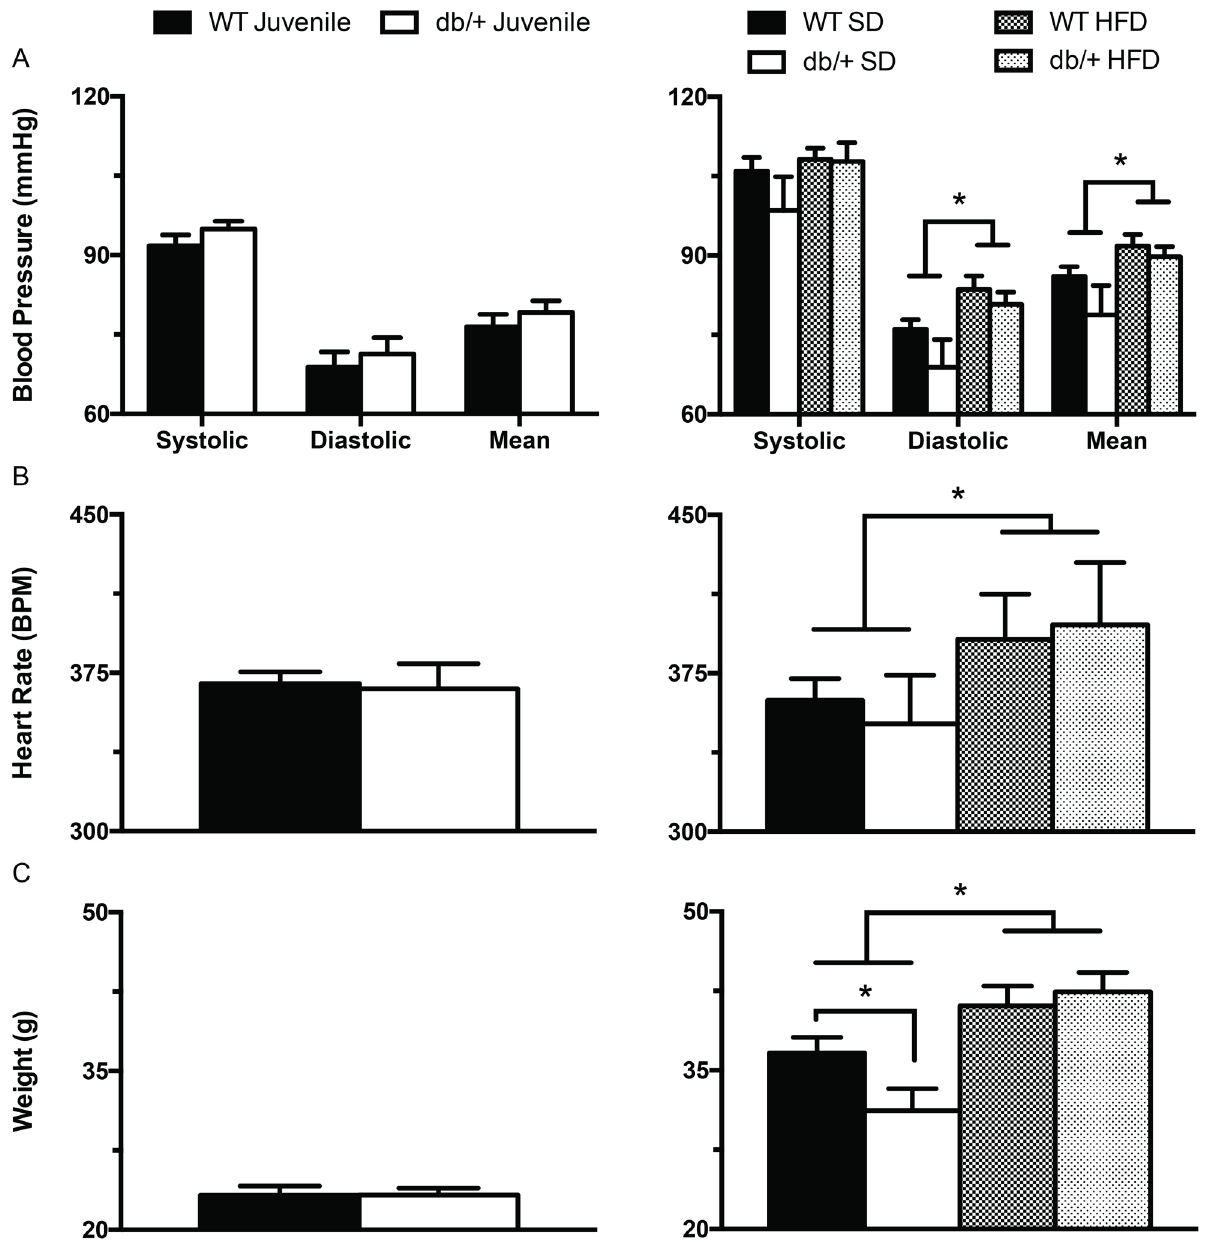
Fig 2. Effect of maternal environment and offspring diet on blood pressure (obtained via carotid catheter), heart rate and body weight of juvenile (6 week-old) and adult (31 week-old) wild type male offspring. (A) Systolic, diastolic and mean arterial pressures in 6 (left panel) and 31 (right panel) week old offspring. (B) Heart rate in 6 (left panel) and 31 (right panel) week old offspring. (C) Body weights in 6 (left panel) and 31 (right panel) week old offspring. Data are means ± SEM of n = 5 – 7 number of animals per treatment group combination. * P < 0.05. WT, wild type; db/+, Lepr db/+ ; SD, standard diet; HFD, high fat